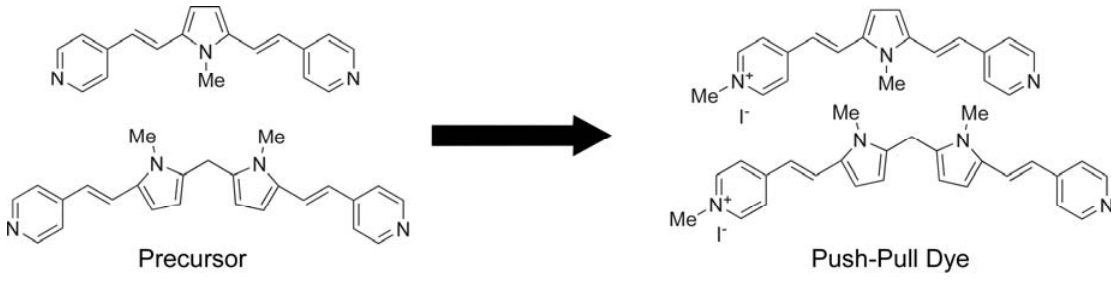
Figure 10. Push-pull dyes and their